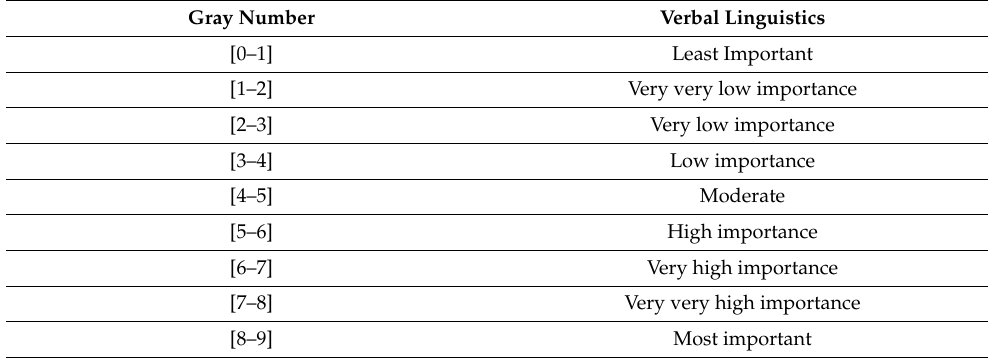
Table 5. Linguistic variables (data from Muneeb et al. [66], Kaviani et al. [67]).